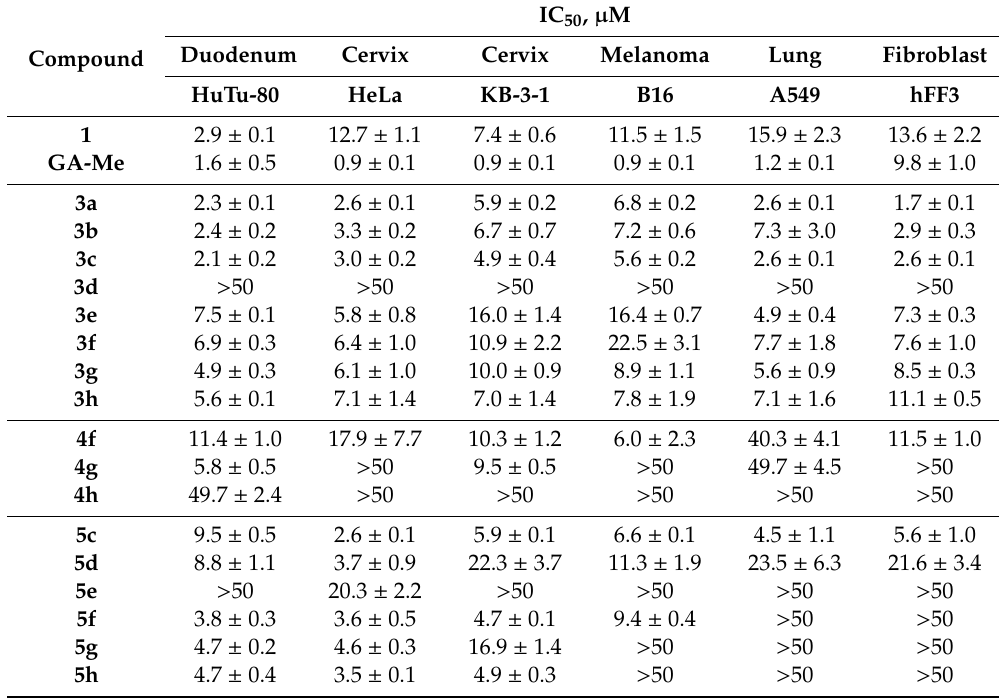
Table 1. Cytotoxicity of novel 18 β H-glycyrrhetinic acid (GA) derivatives.